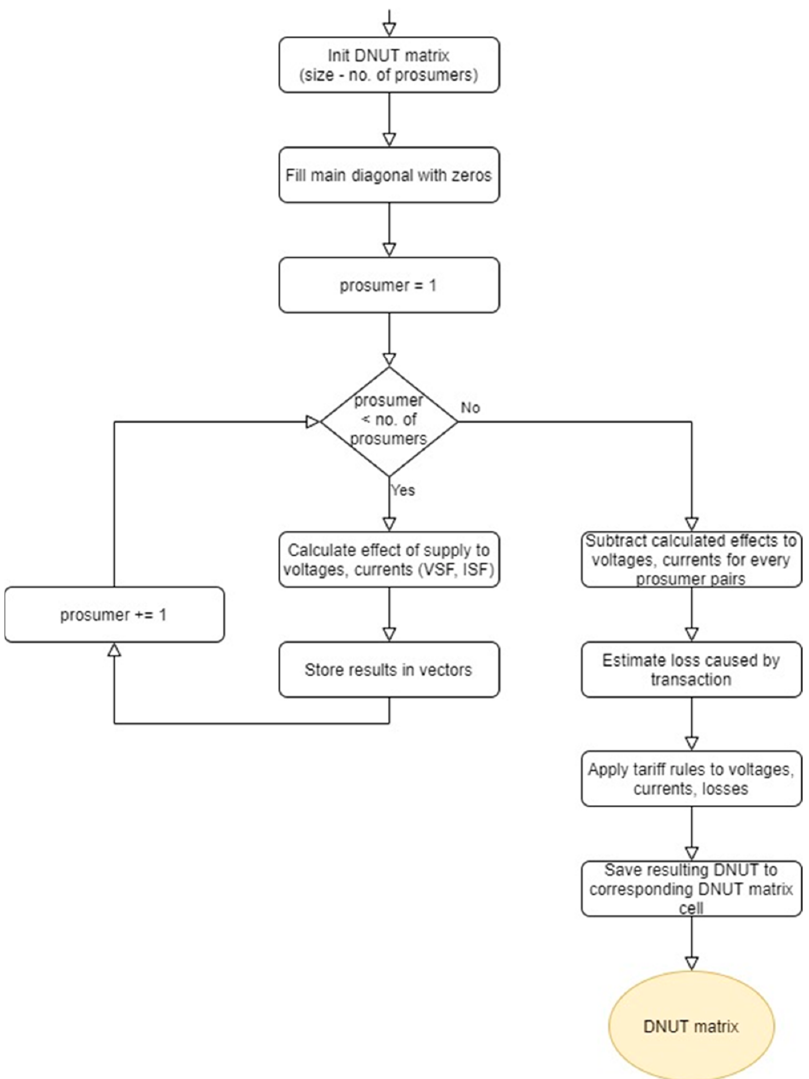
Figure 5. The flowchart of DNUT calculation .